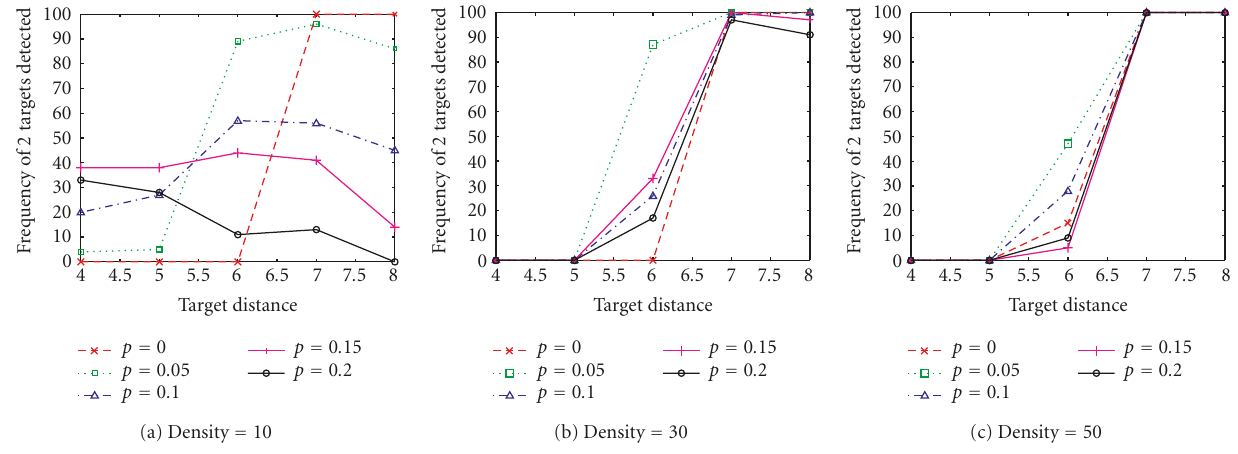
Figure 7: Frequency of two targets detected versus target distance when two targets are deployed, T = 9, and density = 10,30,50, respectively.